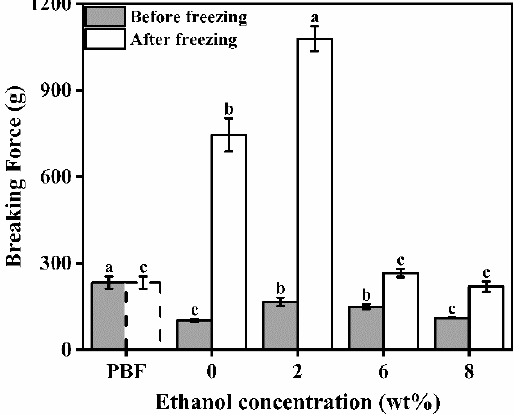
Figure 3. Breaking force of pork back fat (PBF) and konjac emulgel-based fat analogue (KGFA) with different ethanol content before and after freeze-thaw treatment. Dotted line indicates that PBF was not frozen. Different letters indicate significant differences in columns of the same color ( p < 0.05).